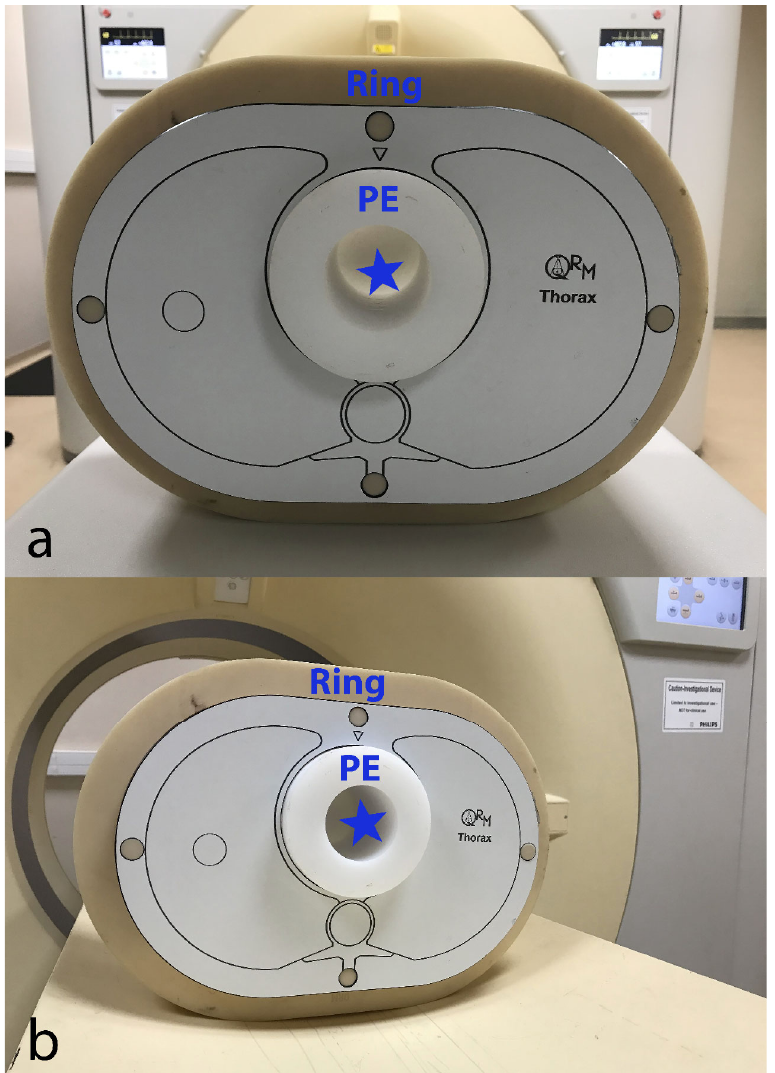
Figure 1. EID ‐ CT ( a ) and SPCCT ( b ) systems with the phantom setup that was placed at the isocenter. CCTA module made of PE is shown with an empty cavity (blue star) to be filled with iodinated contrast material solution for the experiments. The anthropomorphic thorax phantom is shown with a fat ‐ mimicking extension ring (“medium” patient size configuration). CCTA—coronary computed tomography angiography; EID ‐ CT—energy ‐ integrating detector computed tomography; PE—polyethylene; SPCCT—spectral photon ‐ counting computed tomography.